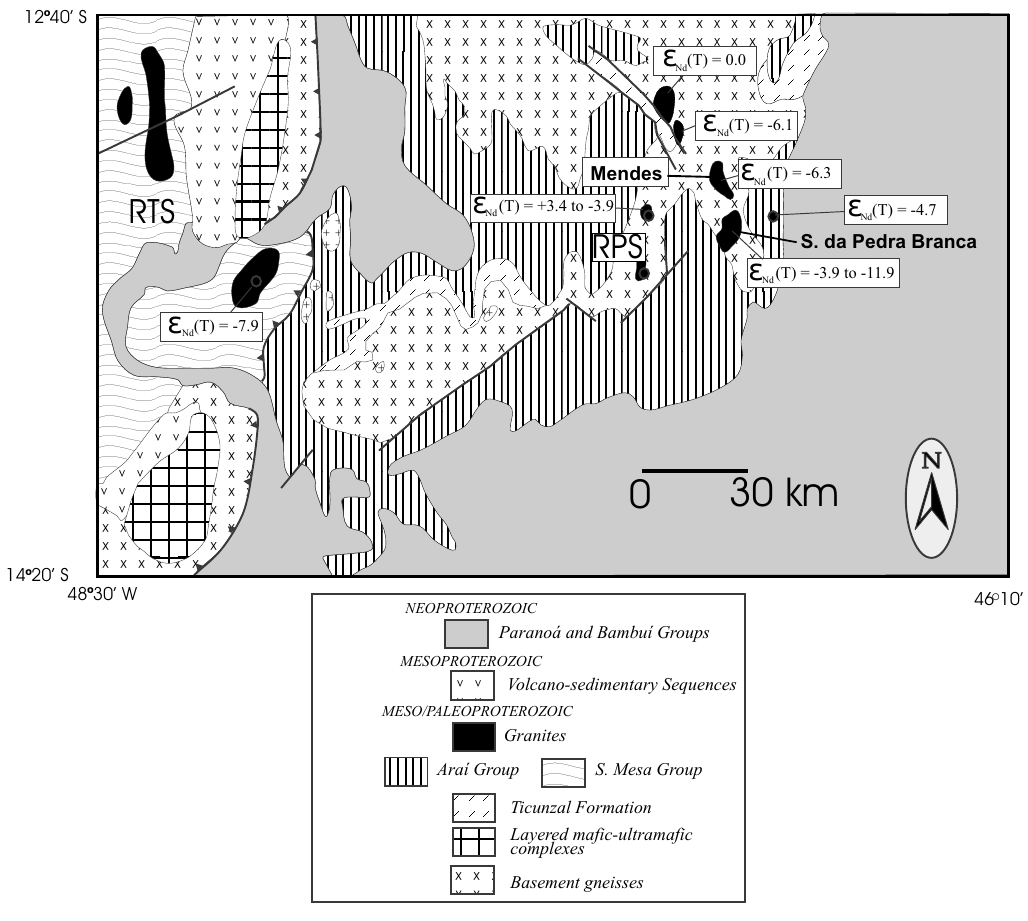
Fig. 2 – Geologic map of the study